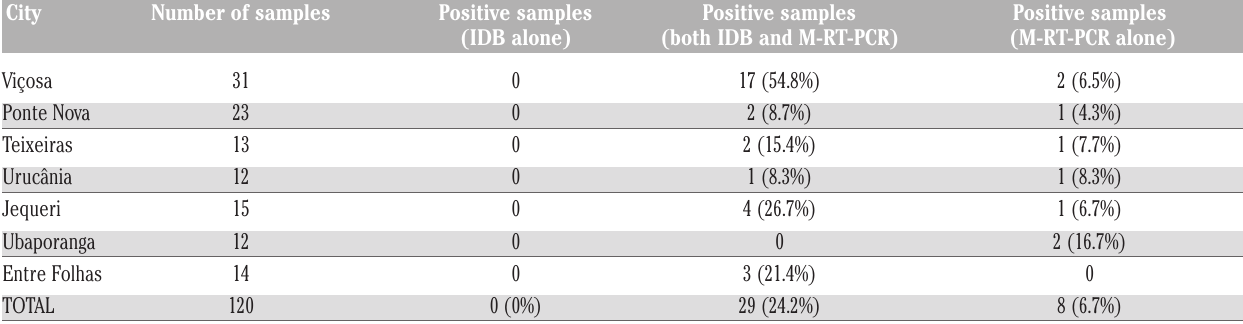
Table 1. Number of samples analyzed in each city showing the number of positive samples to immunodot blot and/or multiplex reverse transcriptase-polymerase chain reaction. City Number of samples Positive samples Positive